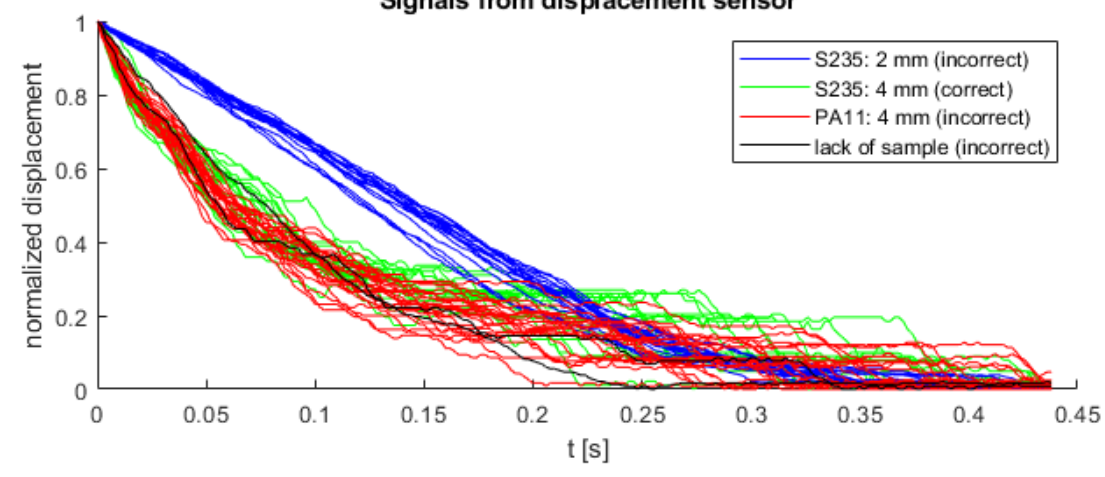
Figure 8. Normalized displacement signals from the extrusion process (first 220 samples). For 220 samples, exemplary approximation of displacement signals by 4th degree polynomial is shown in Figure 9, and detailed classifier parameters (for each degree of polynomial) were presented in Table 1. Classifiers performance was measured with accuracy, along with four additional metrics that are robust to unbalance data [22]: